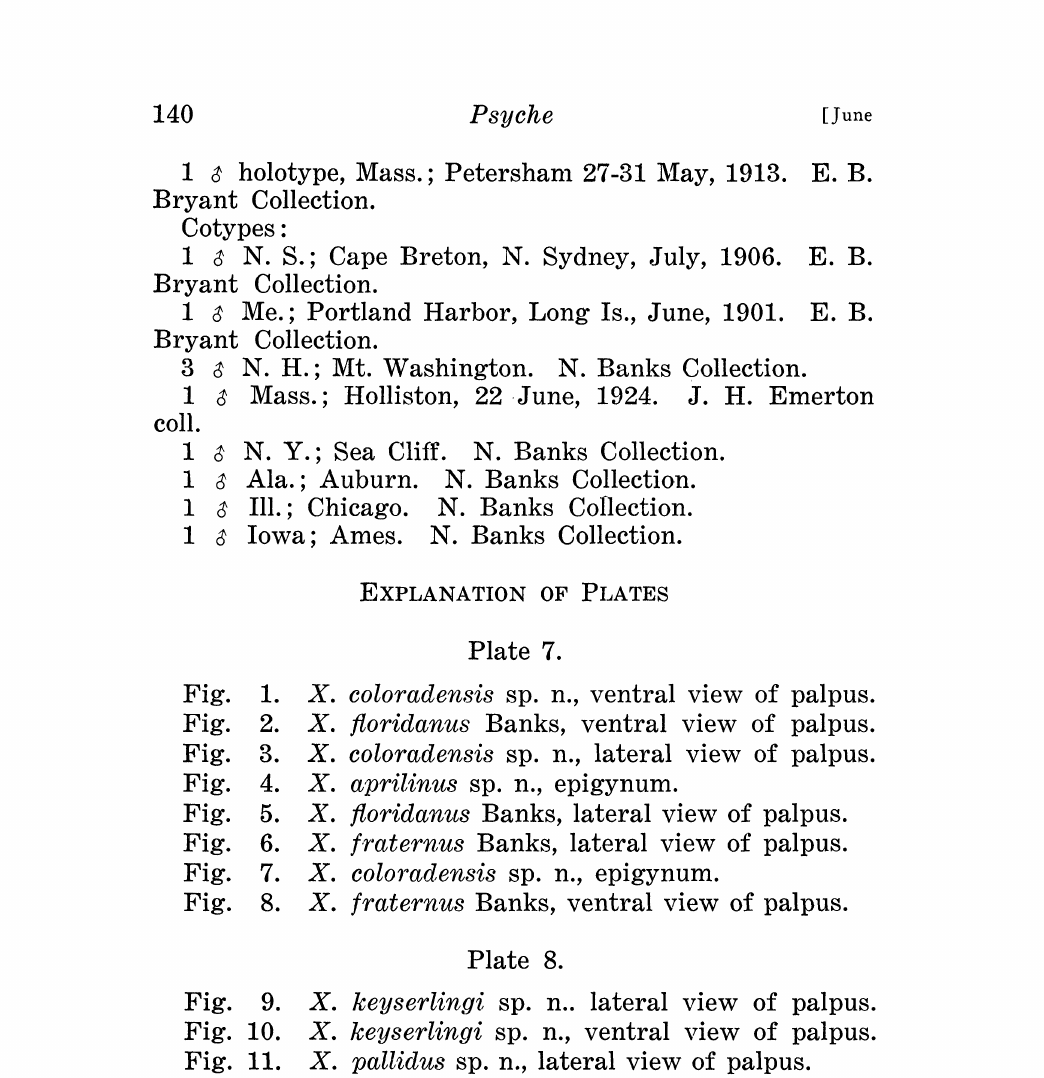
Fig. 1. X. coloradensis sp. n., ventral view of palpus. Fig. 2. X. floridanus Banks, ventral view of palpus. Fig. 3. X. coloradensis sp. n., lateral view of palpus. Fig. 4. X. aprilinus sp. n., epigynum. o palpus. Fig. 5. X. floridanus Banks, lateral view Fig. 6. X. fraternus Banks, lateral view of palpus. Fig. 7. X. coloradensis sp. n., epigynum. Fig. 8. X. fraternus Banks, ventral view of palpus. Plate 8. Fig. 9. X. keyserlingi sp. n.. lateral view oi palpus. Fig. 10. X. keyserlingi sp. n., ventral view of palpus. Fig. 11. X. pallidus sp. n., lateral view of palpus. Fig. 12. X. pallidus sp. n., epigynum. Fig. 13. Xo vernalis sp. n., ventral view of palpus. Fig. 14. X. pallidus sp. n., ventral view of palpus. Fig. 15. X. vernalis sp. n., lateral view of